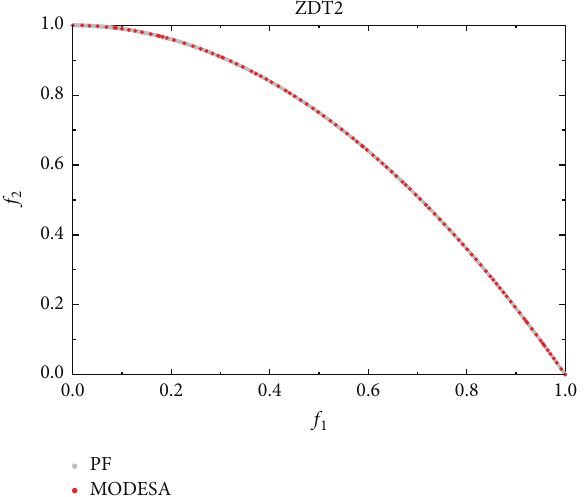
Figure 2: Plots of the nondominated solutions with the lowest IGD- metric values found by MODESA in 10 runs in the objective space on ZDT2 where 𝑁 = 100 and 𝑇 = 250 .